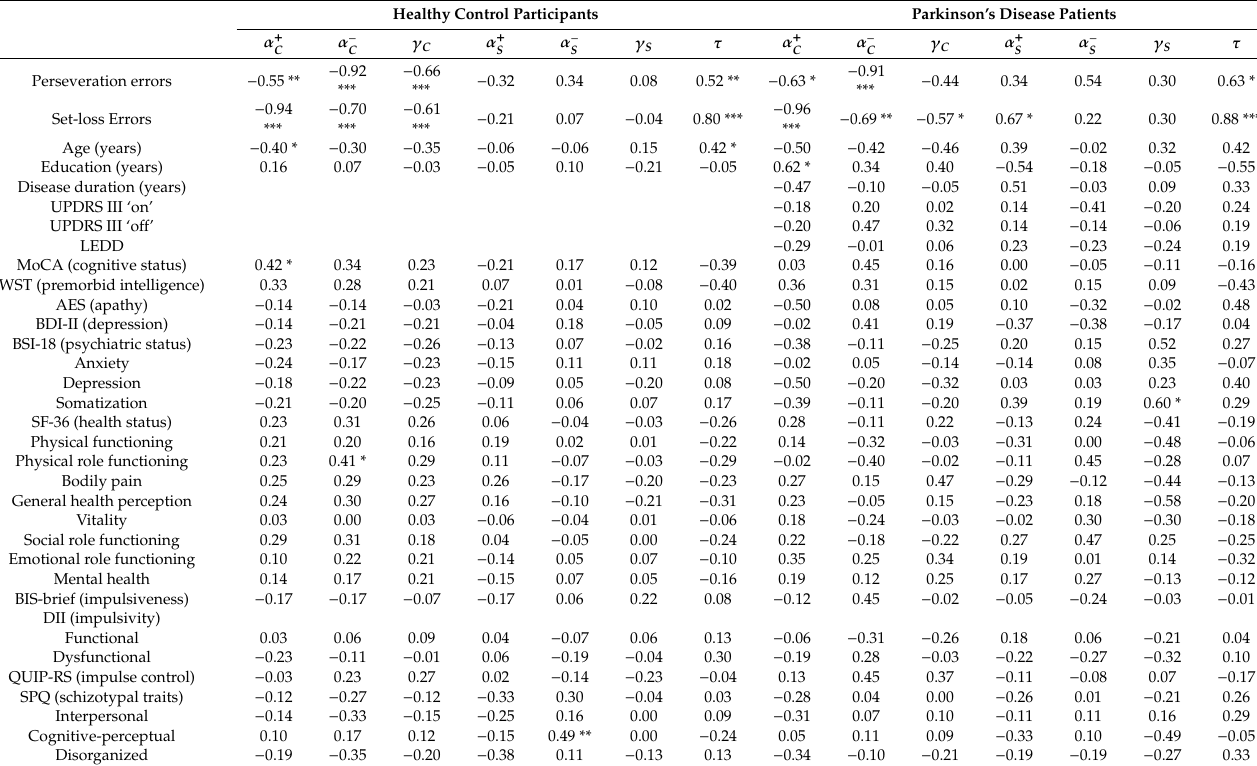
Table A7. Pearson correlation coe ffi cients between model parameters and conditional error probabilities as well as participants’ demographic, clinical, and psychological